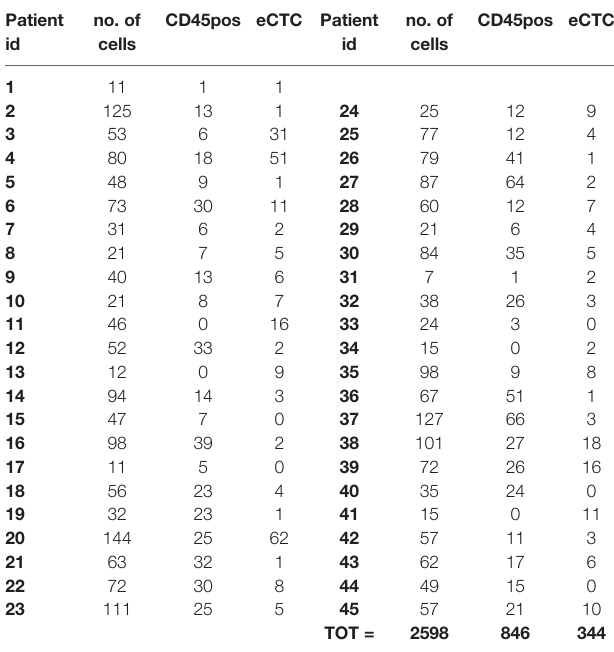
TABLE 2 | Distribution of cells in